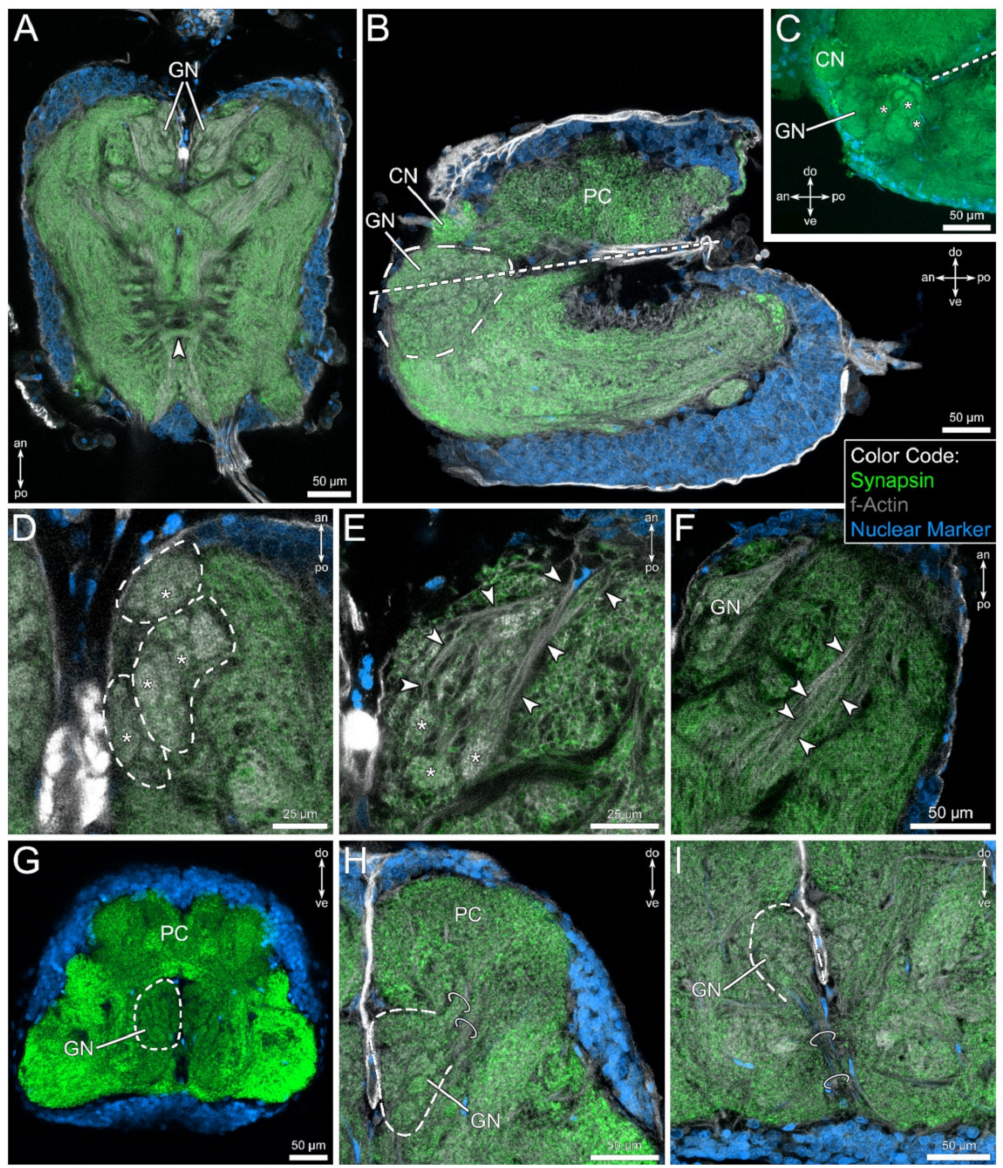
Figure 4. Position and morphology of glomerular structures in the pedipalpal neuropil, revealed by fluorescent labeling of synaptic regions (green), f-actin (gray), and cell bodies (blue). ( A ) In the most dorsal horizontal section (in relation of the subesophageal ganglion) of the synganglion, a conspicuous, drop-shaped neuropil (GN) consisting of glomerular subunits can be observed in antero-medial aspects of the pedipalpal neuromere. Note the commissure in posterior region (arrowhead). ( B , C ) In the sagittal view, the glomerular neuropil (GN) spans spherically around the esophagus, with a fraction lying dorsally, the other part lying ventrally with respect to the esophagus (dashed lines). Asterisks indicate glomeruli. ( D ) In the dorsal view, the arrangement of the glomeruli (asterisks) gives the impression of separated subcompartments (indicated by dashed lines). ( E ) The glomerular neuropil is penetrated by fibers (arrowheads) from the antero-lateral direction, innervating the glomeruli (asterisks). ( F ) Besides the glomerular neuropil, another distinct neuropil is found postero-laterally, having a stratified appearance of parallel fibers (arrowheads). ( G – I ) Frontal views on the glomerular neuropil (highlighted by dashed lines), showing a spheric to drop-shaped appearance. The glomerular neuropil is connected to dorsal, protocerebral regions by two distinct tracts (rings in ( H )). Ventrally, fibers connect the glomerular neuropil to the ventral soma cortex (rings in ( I )). Other abbreviations: an: anterior; CN: cheliceral neuropil; do: dorsal; PC: protocerebrum; po: posterior; ve: